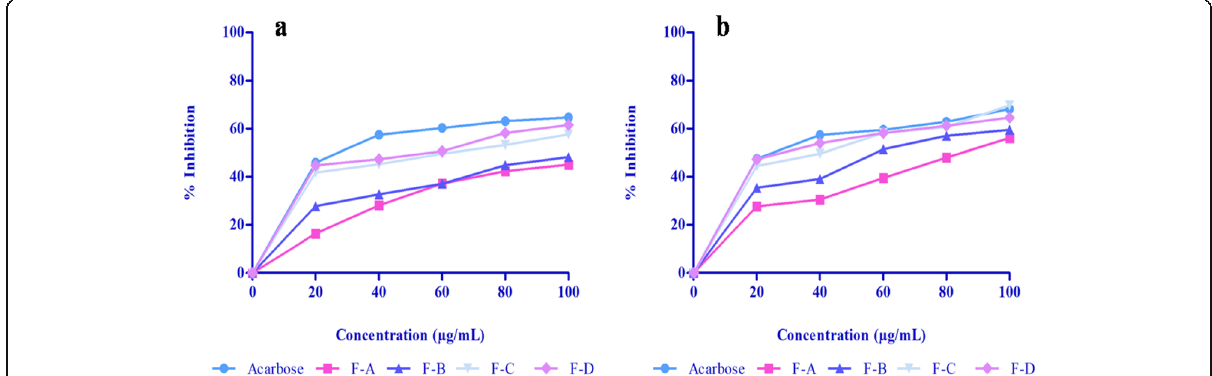
Fig. 7 a α -Glucosidase and b α -amylase inhibition activity of MeCV isolated pooled fractions and acarbose